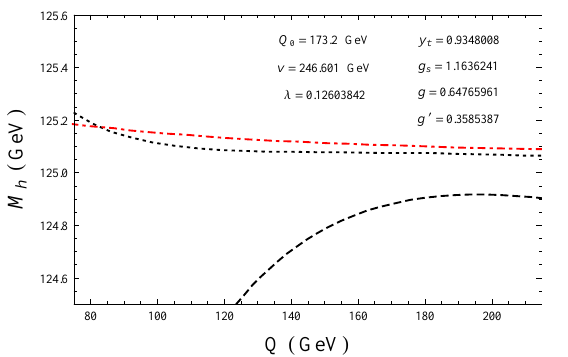
Figure 1. Renormalized Higgs boson mass in the tadpole-free MS scheme at full one-loop (dashed), full two-loop (dotted), and three-loop leading logarithms (dot-dashed red) levels as a function of the renormalization scale Q